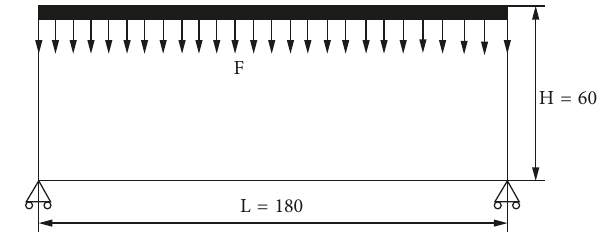
Figure 2: Design space of the deck arch bridge.